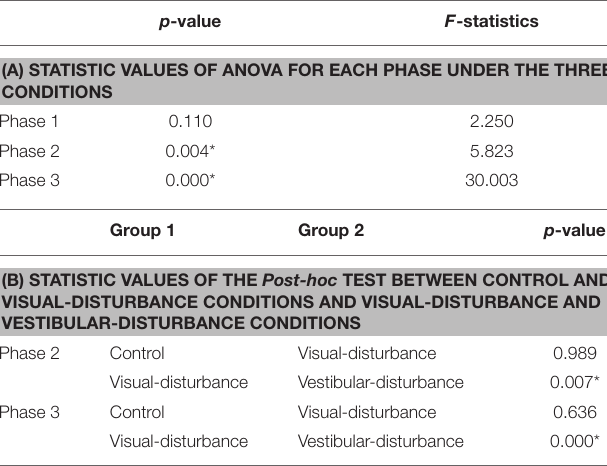
TABLE 3 | Duration of temporal patterns compared for each phase under the three